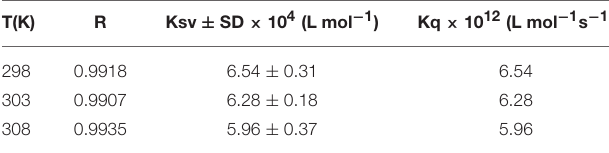
TABLE 1 | Stern–Volmer quenching constants (K SV ) and bimolecular quenching rate constant (Kq) for the binding of neratinib to BSA at three different